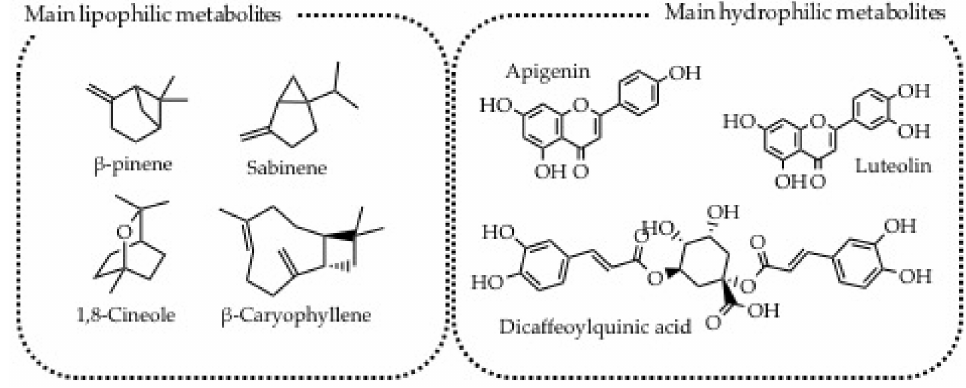
Figure 4. Most abundant secondary metabolites produced by Achillea millefolium